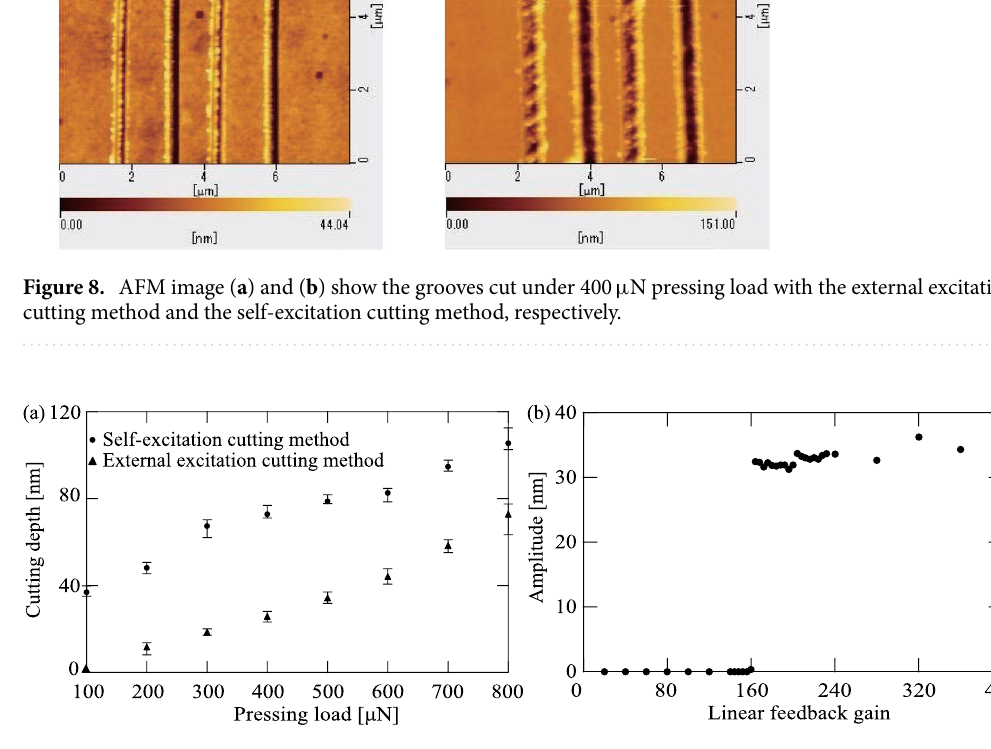
Figure 9. Depths of grooves cut under each pressing load with two types of cutting method ( a ). The triangles and the dots represent the depths using the external excitation cutting method and the self-excitation cutting method, respectively. Change in amplitude caused by controlling linear feedback gain k lin [1/s] under application of a 400 µ N pressing load ( b